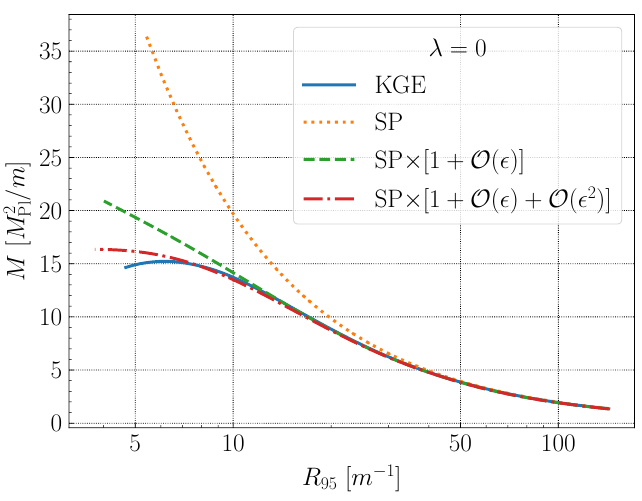
Figure 3 . A comparison of the mass-radius relation for the free theory ( λ = 0 ) obtained from the Klein-Gordon-Einstein (KGE) equations, the Schrödinger-Poisson (SP) equations, and our nonrel- ativistic effective field theory that includes O ( (cid:15) ) and O ( (cid:15) 2 ) corrections beyond the SP equations. When the system becomes mildly relativistic, R 95 ∼ 10 m − 1 , the SP equations show increasing dis- agreement with the fully relativistic results obtained from the KGE equations. On the other hand, our effective equations with just the leading relativistic corrections improve the results significantly. Furthermore, the O ( (cid:15) 2 ) corrections also capture the qualitative behavior when the system becomes highly